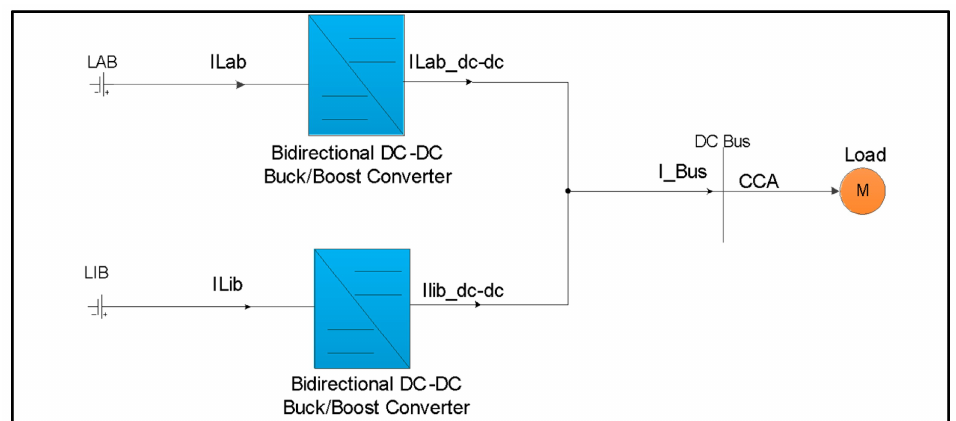
Figure 9. The proposed HESS architecture current flow.